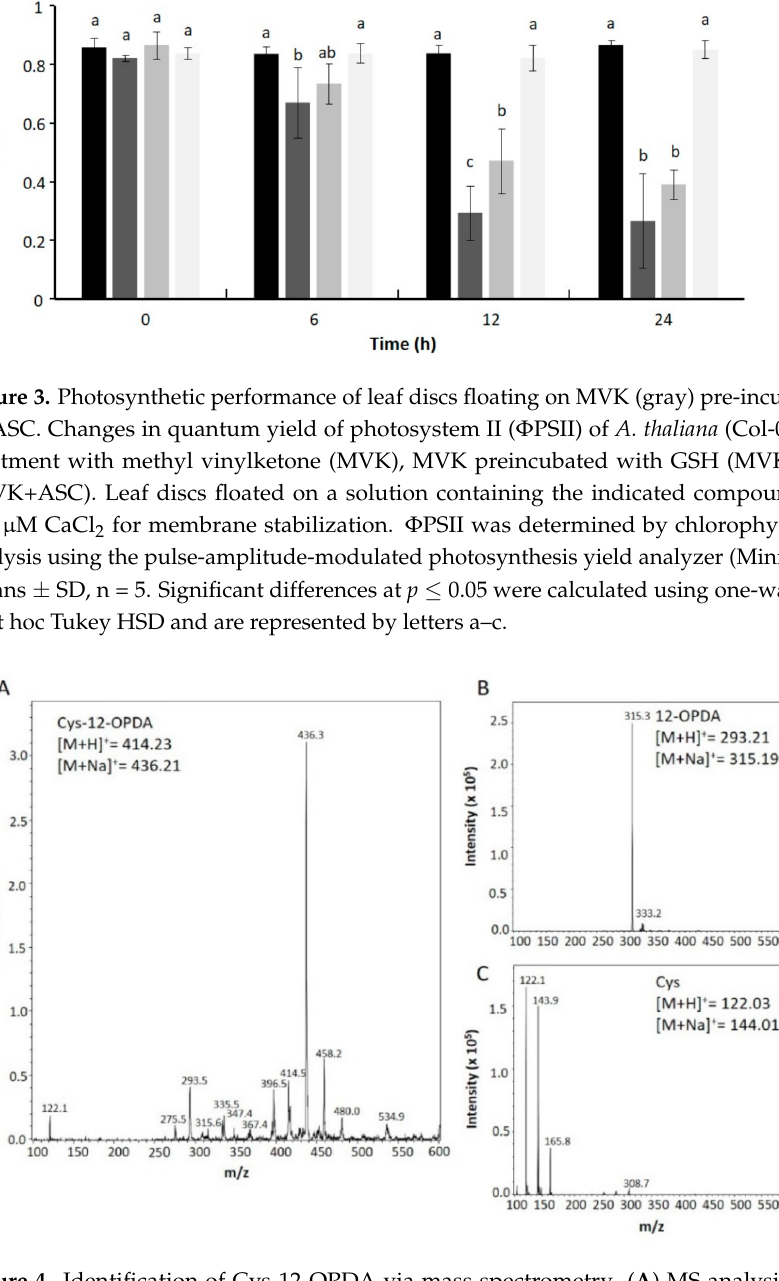
Figure 4. Identification of Cys-12-OPDA via mass spectrometry. ( A ) MS analysis of the product formed after incubation of Cys with 12-OPDA revealed Cys-12-OPDA as the main product. The incubation without addition of either 12-OPDA or Cys is also presented ( B , C ). The insets depict molecular masses and the expected m / z ratios of the indicated main products. ESI-MS spectrum was recorded via Bruker Daltonics Esquire 3000 in positive ionization mode. For details, see Section